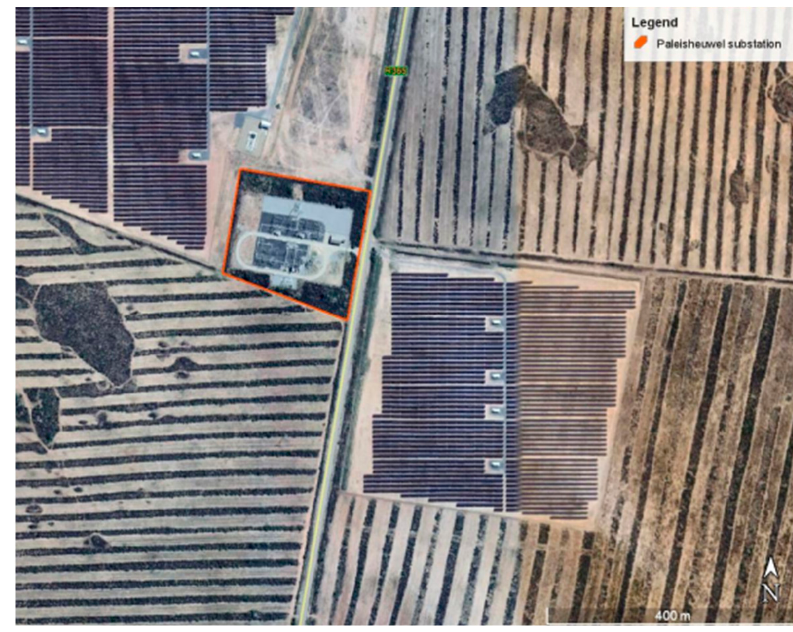
Figure 14. Eskom Paleisheuwel, Western Cape province.